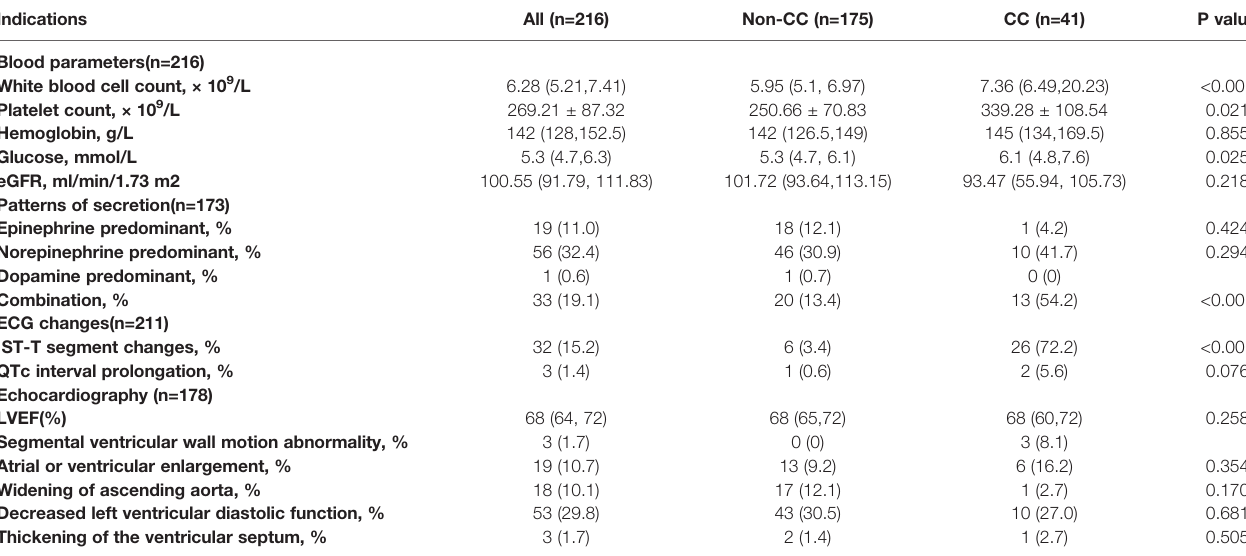
TABLE 2 | Laboratory, electrocardiographic, and echocardiographic fi ndings of patients diagnosed with PPGLs and comparisons between the non-CC and CC groups. Indications All